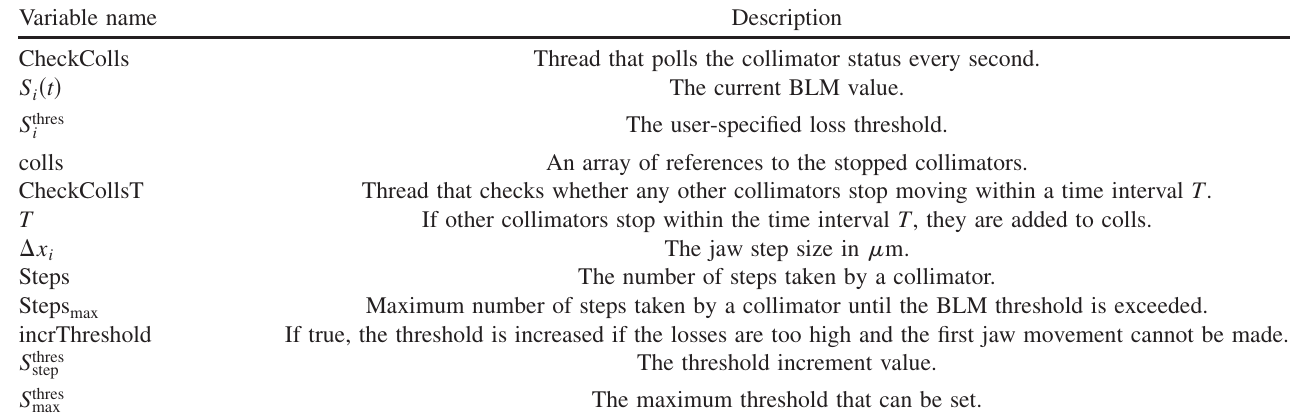
TABLE III. Overview of the variables and objects used in the parallel